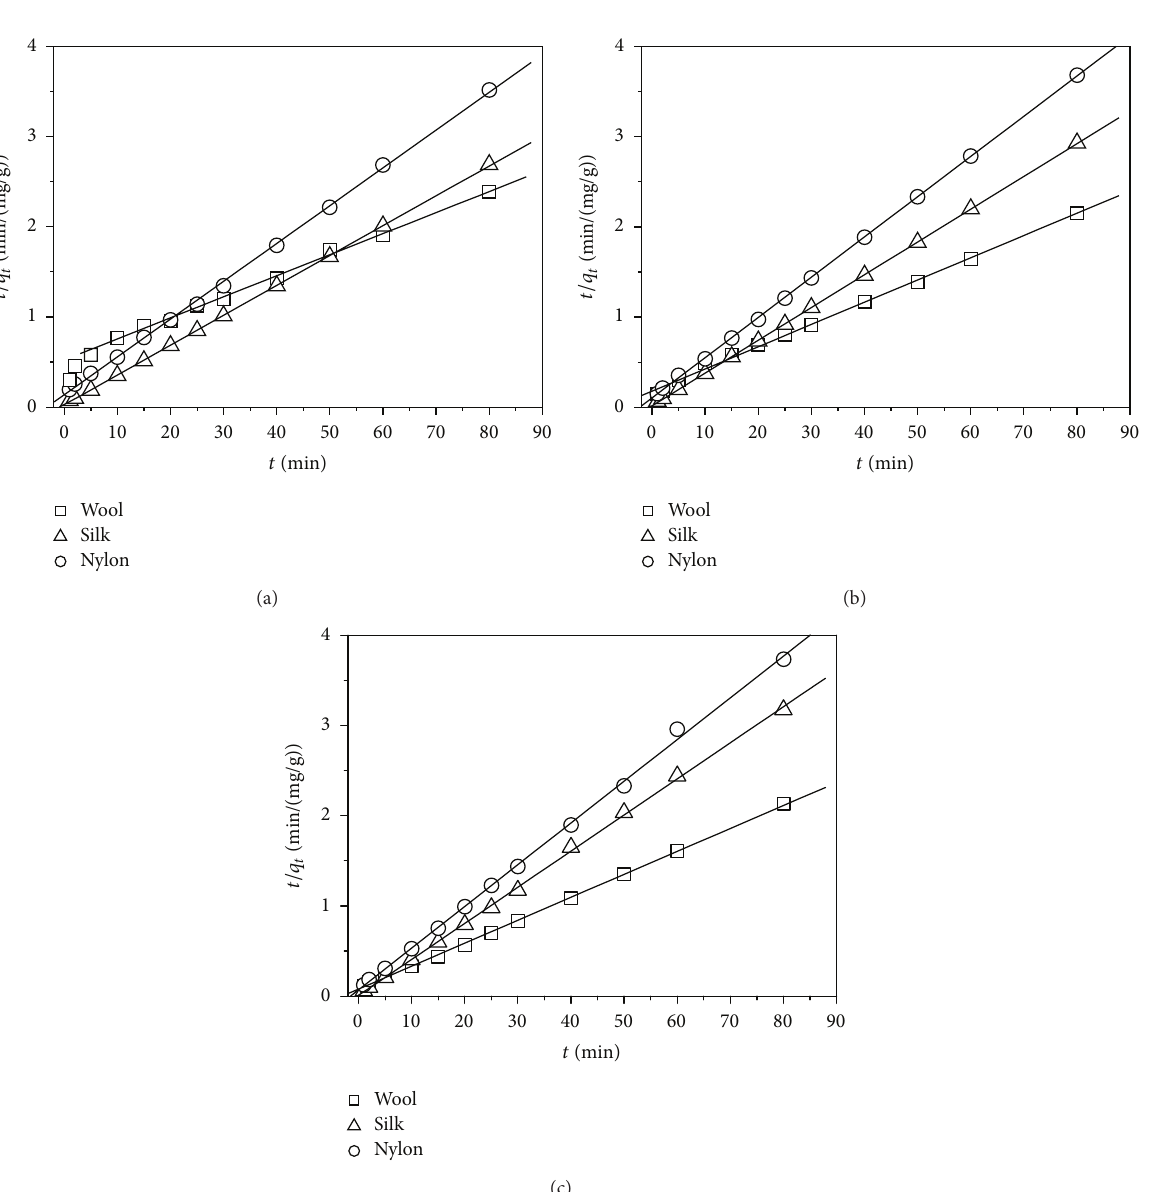
Figure 2: Plots of 𝑡/𝑞 𝑡 against 𝑡 for the adsorption of lac dyes on wool, silk, and nylon at 70 ∘ C (a), 80 ∘ C (b), and 90 ∘ C